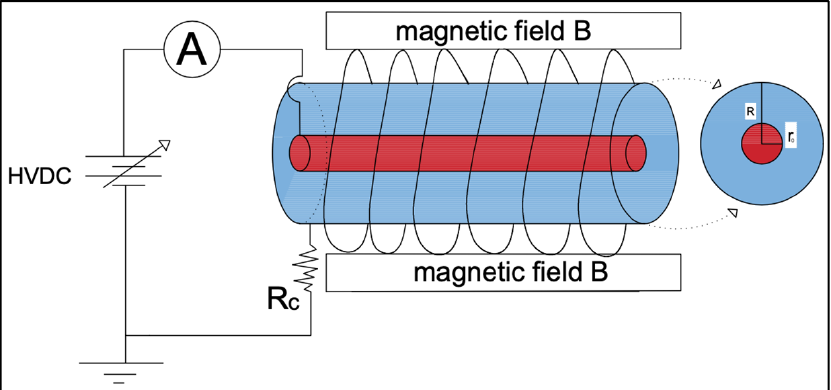
Figure 2. The schematic diagram of the experimental setup.